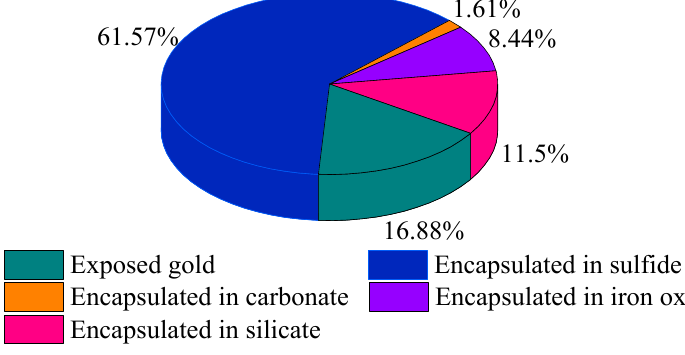
Figure 2. The occurrence of gold in different phases of Carlin-Type gold ore.